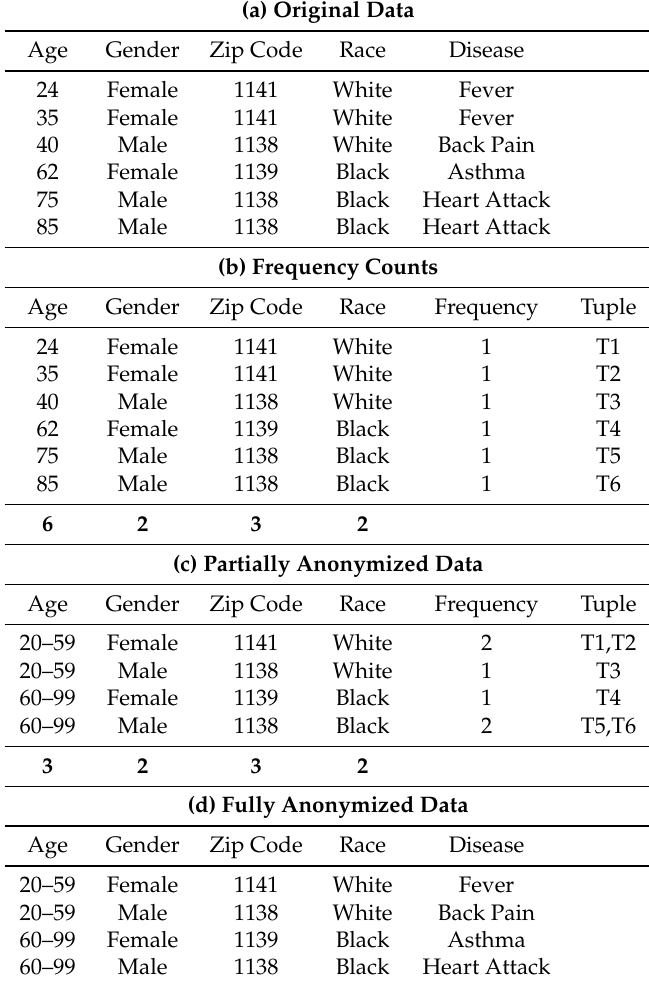
Table 1. Data Anonymization